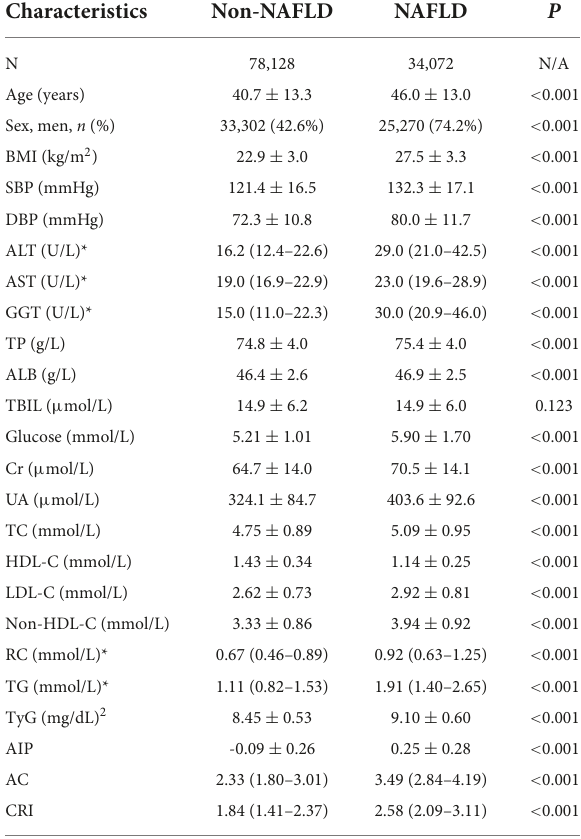
TABLE 1 Comparison of clinical characteristics and metabolic parameters between subjects with NAFLD and those without NAFLD.